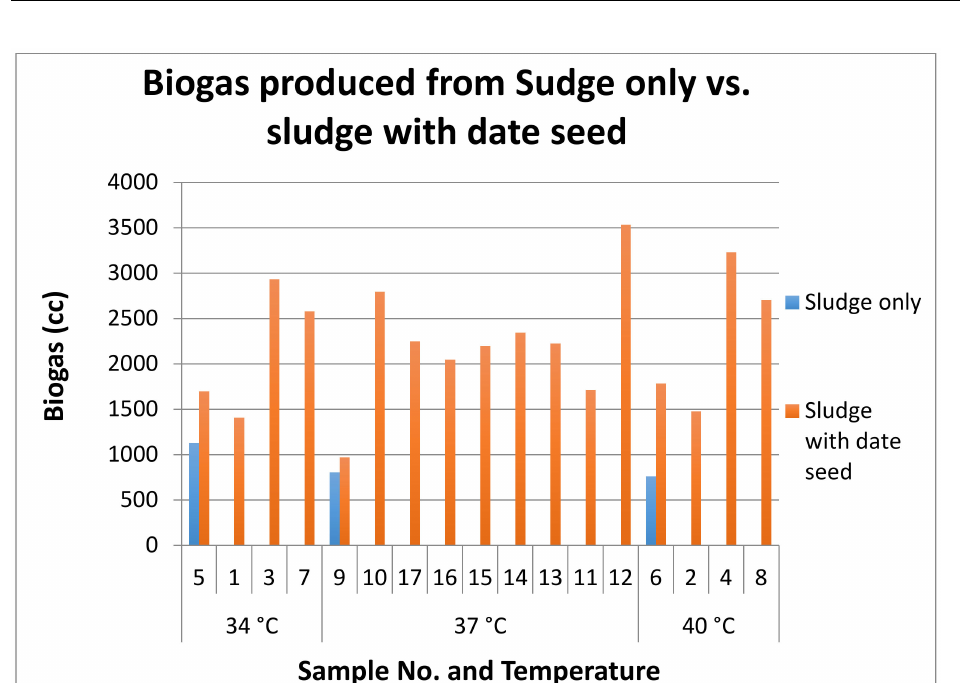
Figure 19. The considerable increase in biogas yield by adding extracted oil date